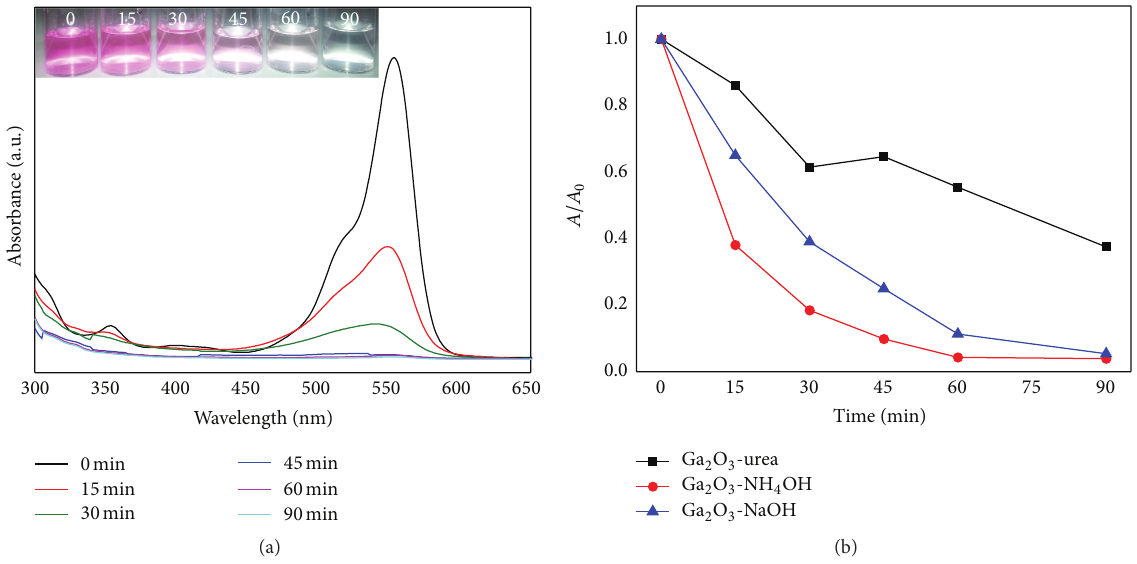
Figure 6: (a) The UV-visible absorption spectra of RhB solution in the presence of Ga 2 O 3 crystals (prepared by the precipitation of GaCl 3 solution with NH 4 OH) under UVC light (254 nm) irradiation; (b) photodegradation curve of Ga 2 O 3 samples as a function of irradiation